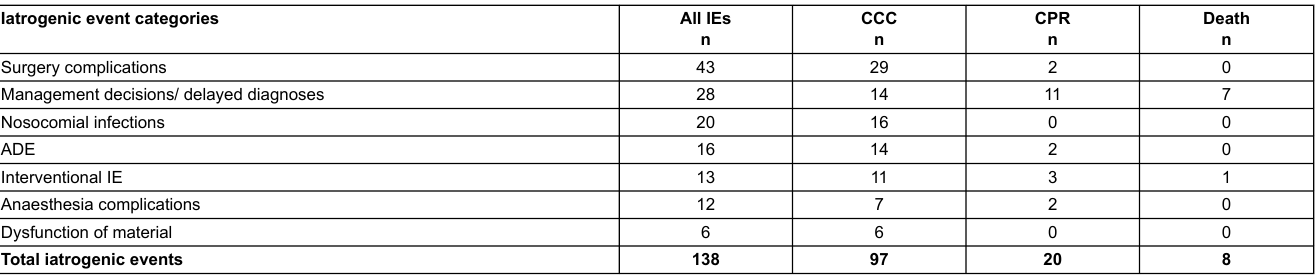
Table 2: Iatrogenic events by categories. Iatrogenic event